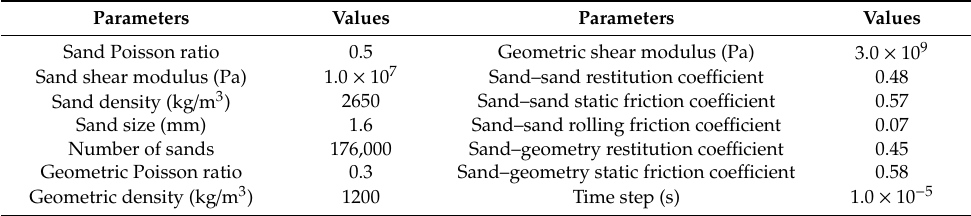
Table 3. DEM parameters used in simulations.